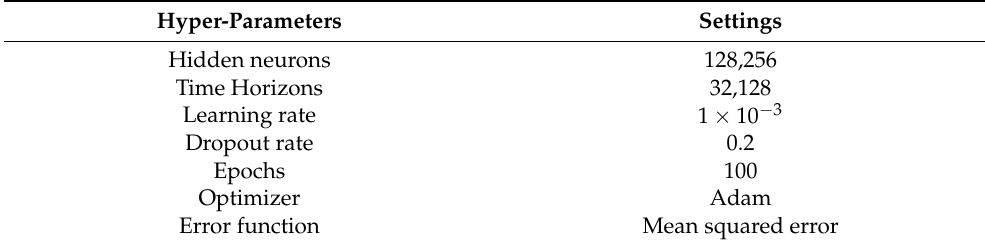
Figure 8. Model structure for time series prediction. Table 2. Hyper ‐ parameters setting list. Table 2. Hyper-parameters setting